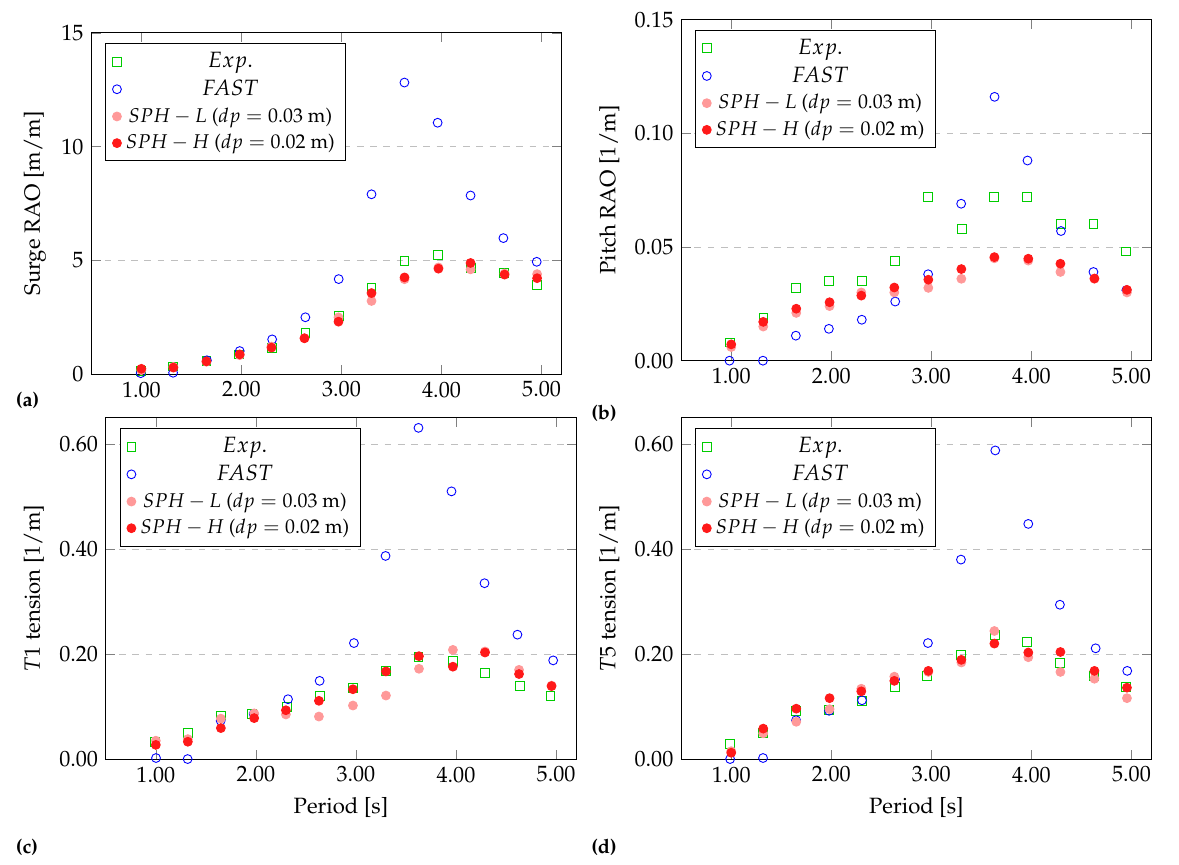
Figure 6. Surge ( a ), pitch ( b ), T 1 maximum tension ( c ), and T 5 maximum tension ( d ) response spectra under regular waves: experimental, numerical (FAST), and proposed model results comparison for two resolutions ( SPH-L and SPH-H ).